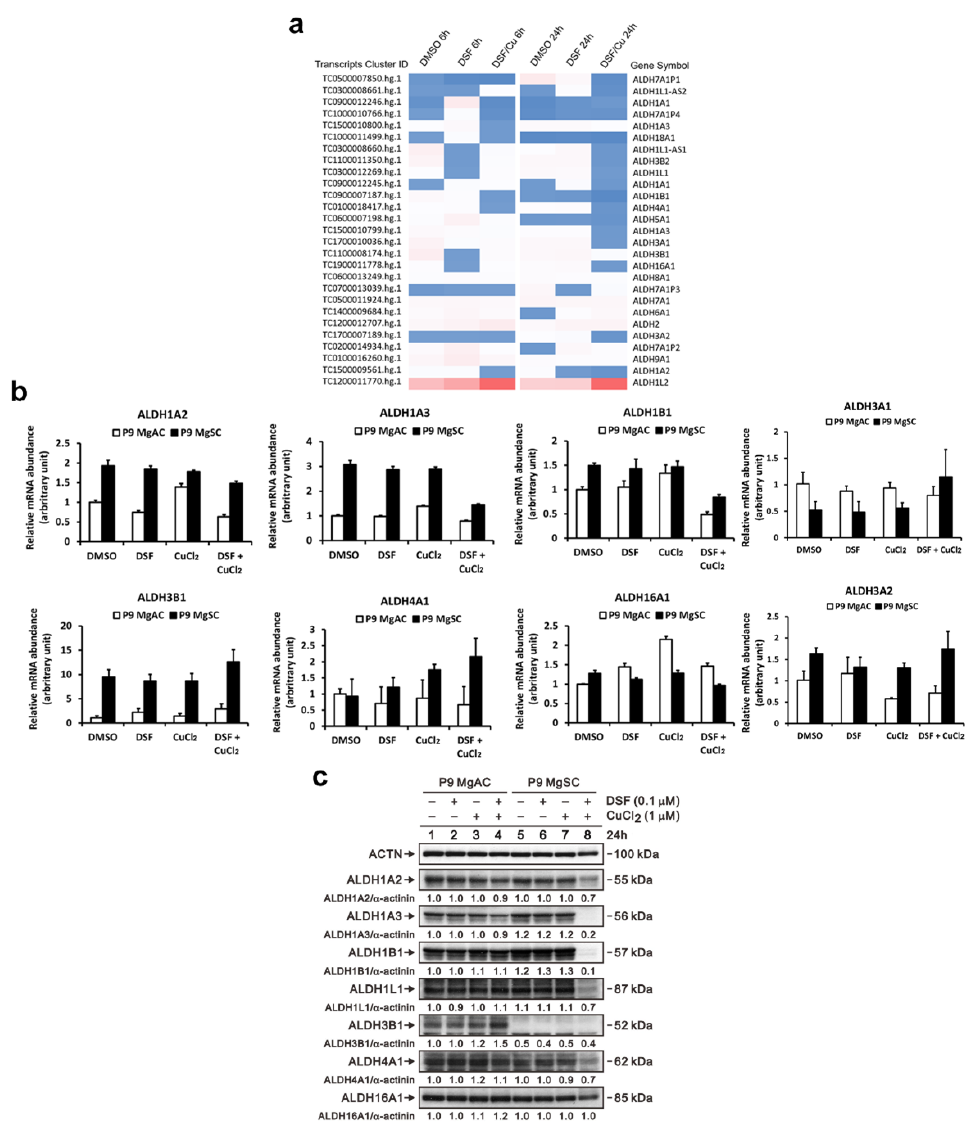
Figure 8. DSF/Cu inhibits different ALDH isoforms’ expressions in MgACs and MgSCs. ( a ) Heatmap showing normalized gene expression from a microarray database analysis and highlighting signifi- cantly up- and downregulated ALDH isoforms in MgACs treated for 6 h or 24 h with DMSO, 0.1 µ M DSF, or 0.1 µ M DSF/1 µ M CuCl 2 . Expression of ALDH isoforms was verified using qRT-PCR ( b ), and Western blot ( c ) with MgACs and MgSCs incubated for 24 h with 0.1 µ M DSF and 1 µ M CuCl 2 ; α -actinin served as a loading control. The quantitative data with normalized internal control are labeled below each protein